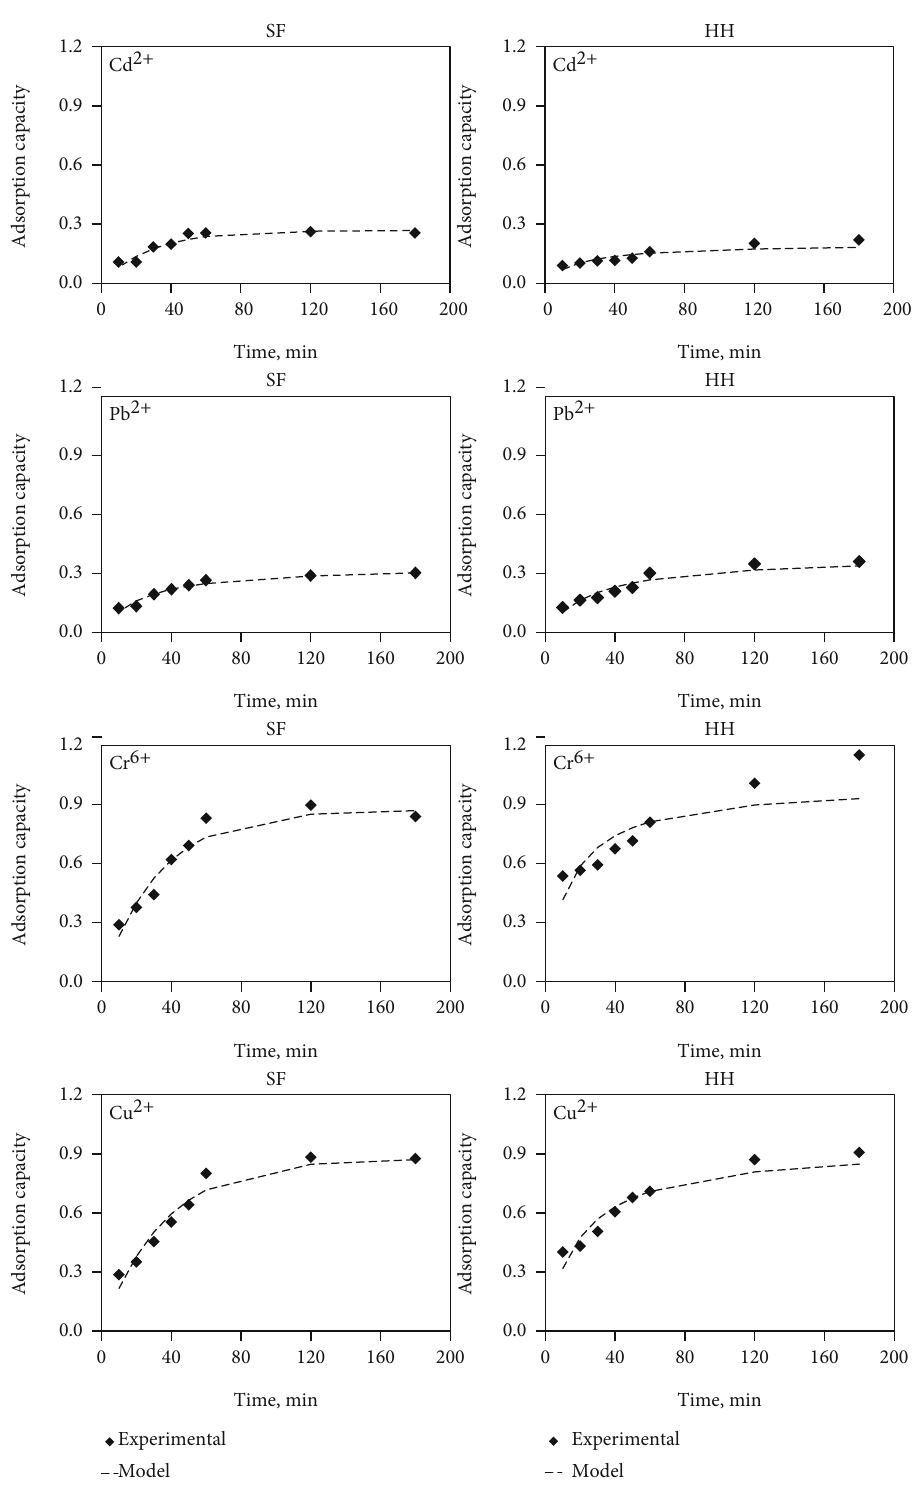
Figure 5: Kinetics of the adsorption of heavy metal ions from aqueous solutions using SF and HH at 298K and pH 4. Initial metal concentration of